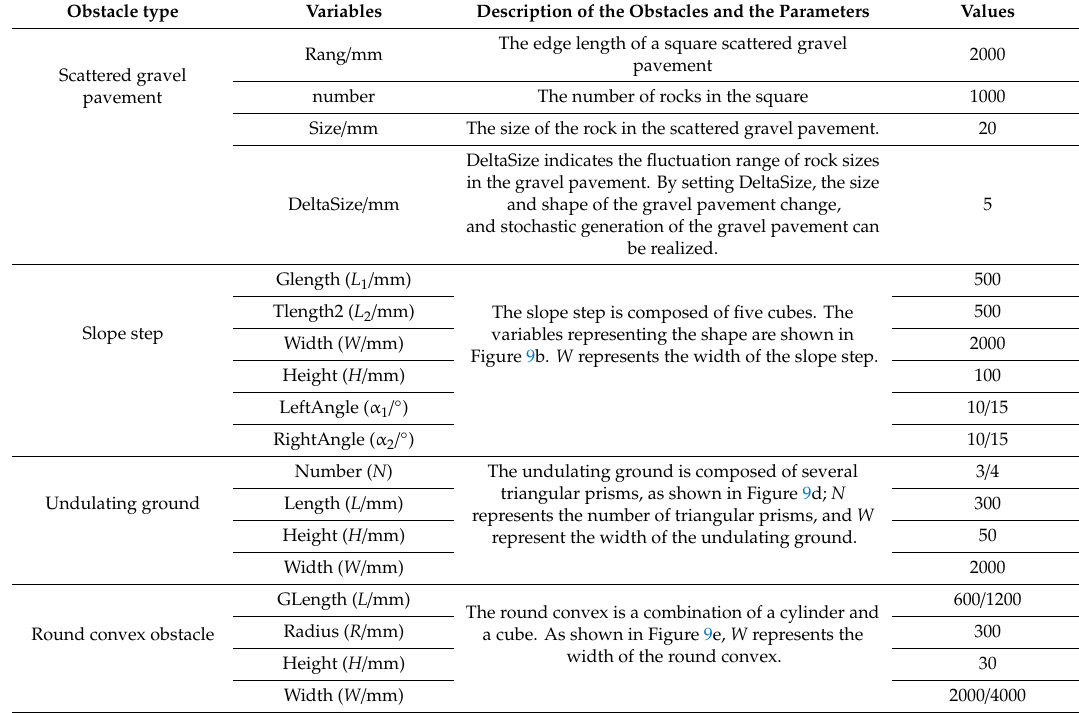
Table 5. The parameters of the test terrain platform.